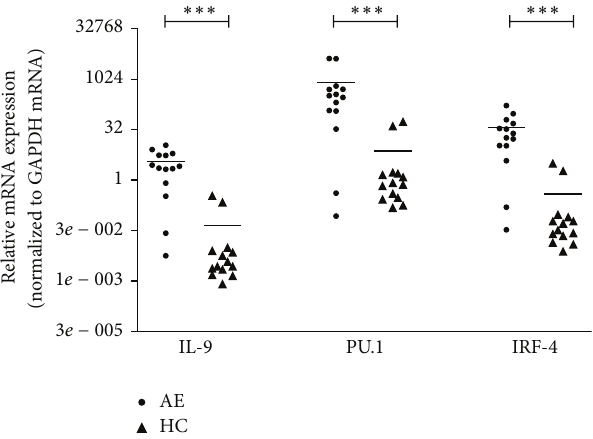
Figure 1: The expression levels of cytokine and transcription factors in PBMCs in AE and HC group. AE: alveolar echinococcosis; HC: healthy control. 𝑃 value < 0.001 with marker ∗ ∗ ∗ ; 𝑃 value 0.001 to 0.01 with marker ∗∗ ; 𝑃 value 0.01 to 0.05 with marker ∗ ; 𝑃 value > 0.05 is not